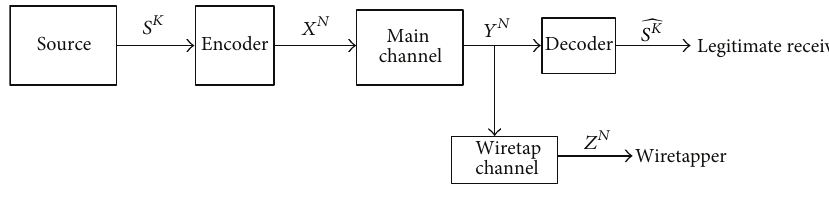
Figure 1: Wiretap channel.